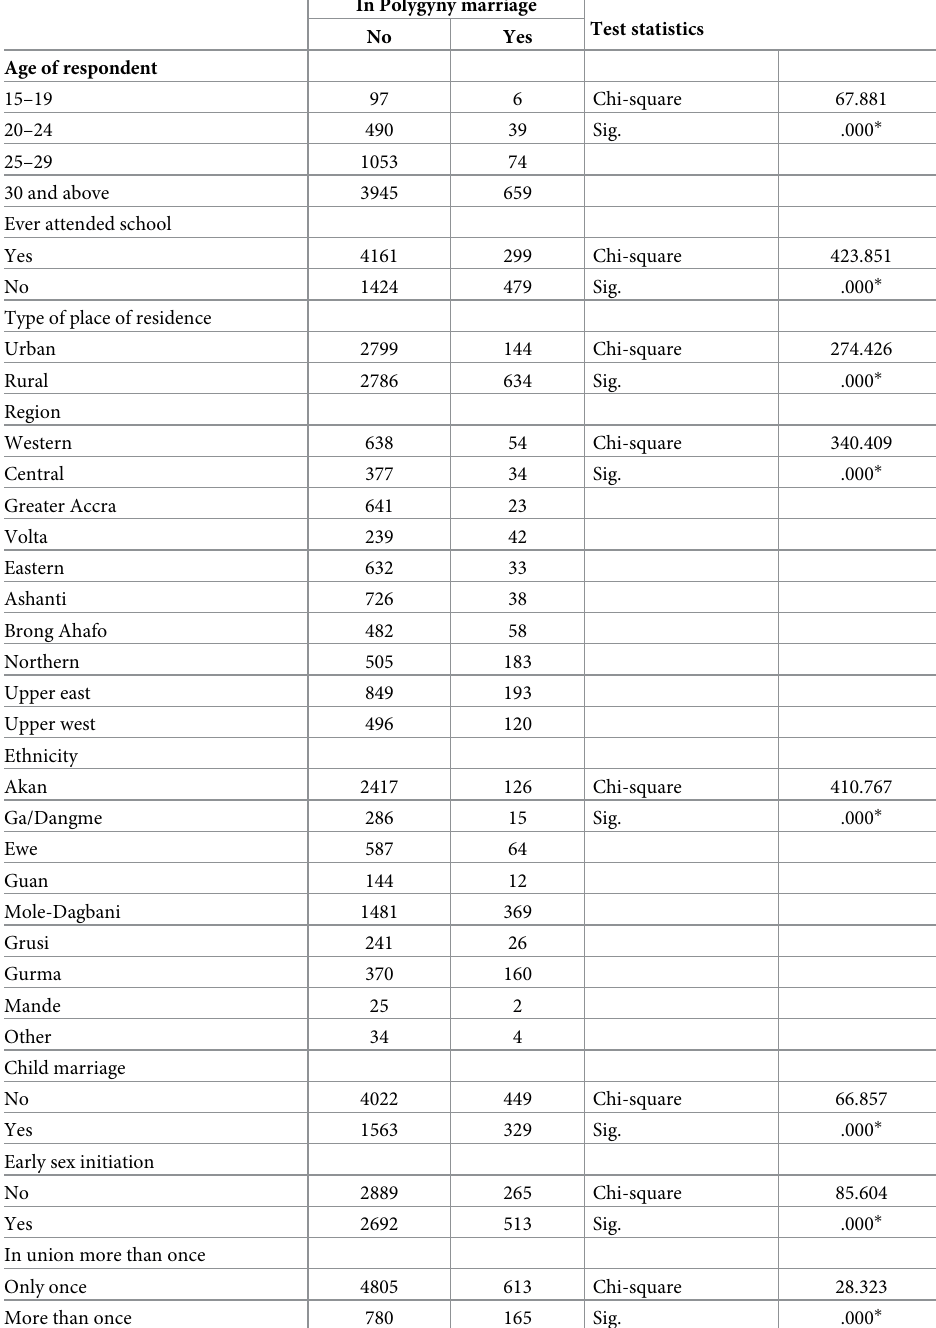
Table 2. Chi-square analysis of factors associated with polygyny marriage relations among Christian women of Ghana.